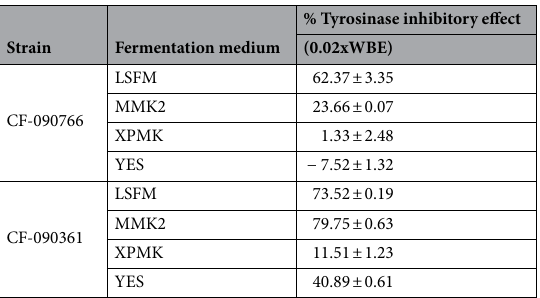
Table 1. Anti-tyrosinase activity of extracts from CF-090361 and CF-090766 cultivated in 4 fermentation media 20 (Extracts were tested at a concentration corresponding to 0.02xWBE dilution (Whole Broth Equivalent)).